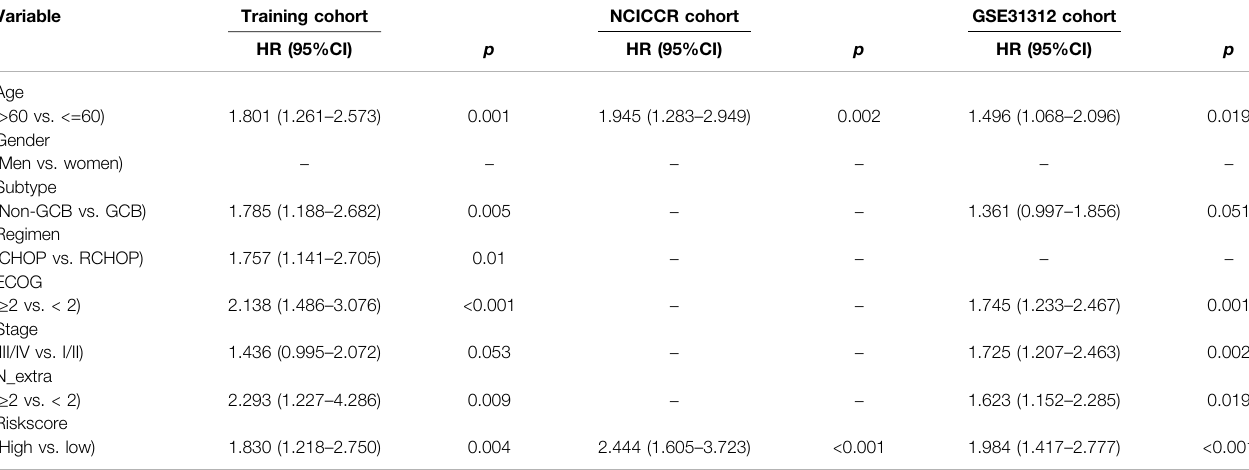
TABLE 3 | Multivariate Cox regression analysis of overall survival in the training and validation cohorts. Variable